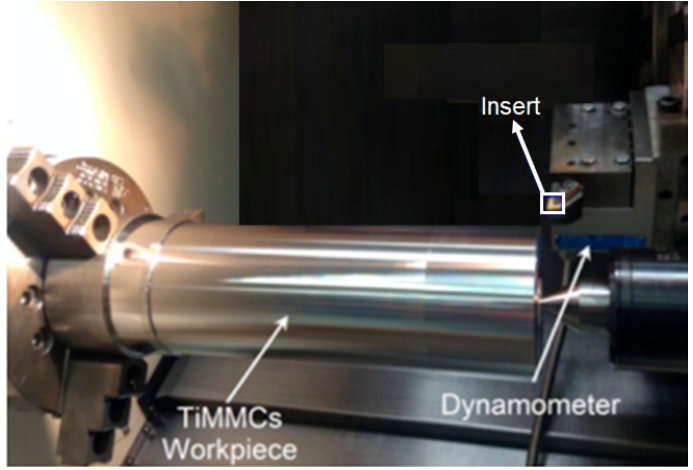
Figure 1. Experimental set-up used.